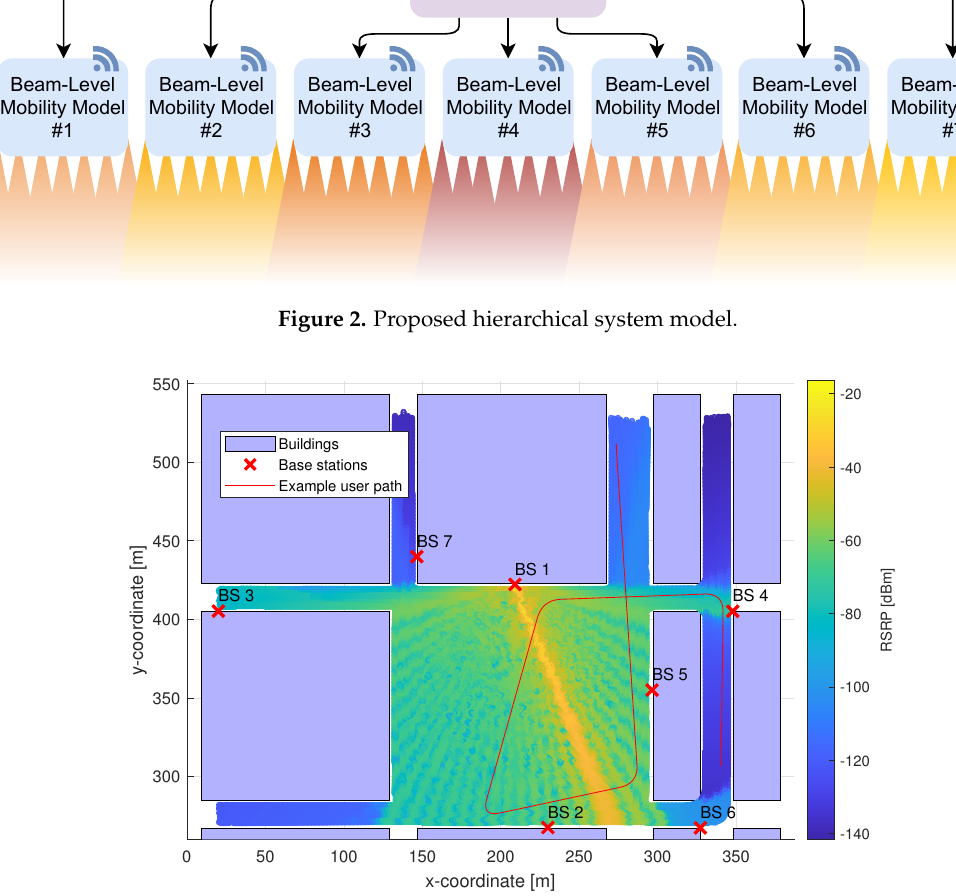
Figure 3. The considered network deployment with highlighted buildings, base station (BS) positions, example user path, and an example coverage of a single